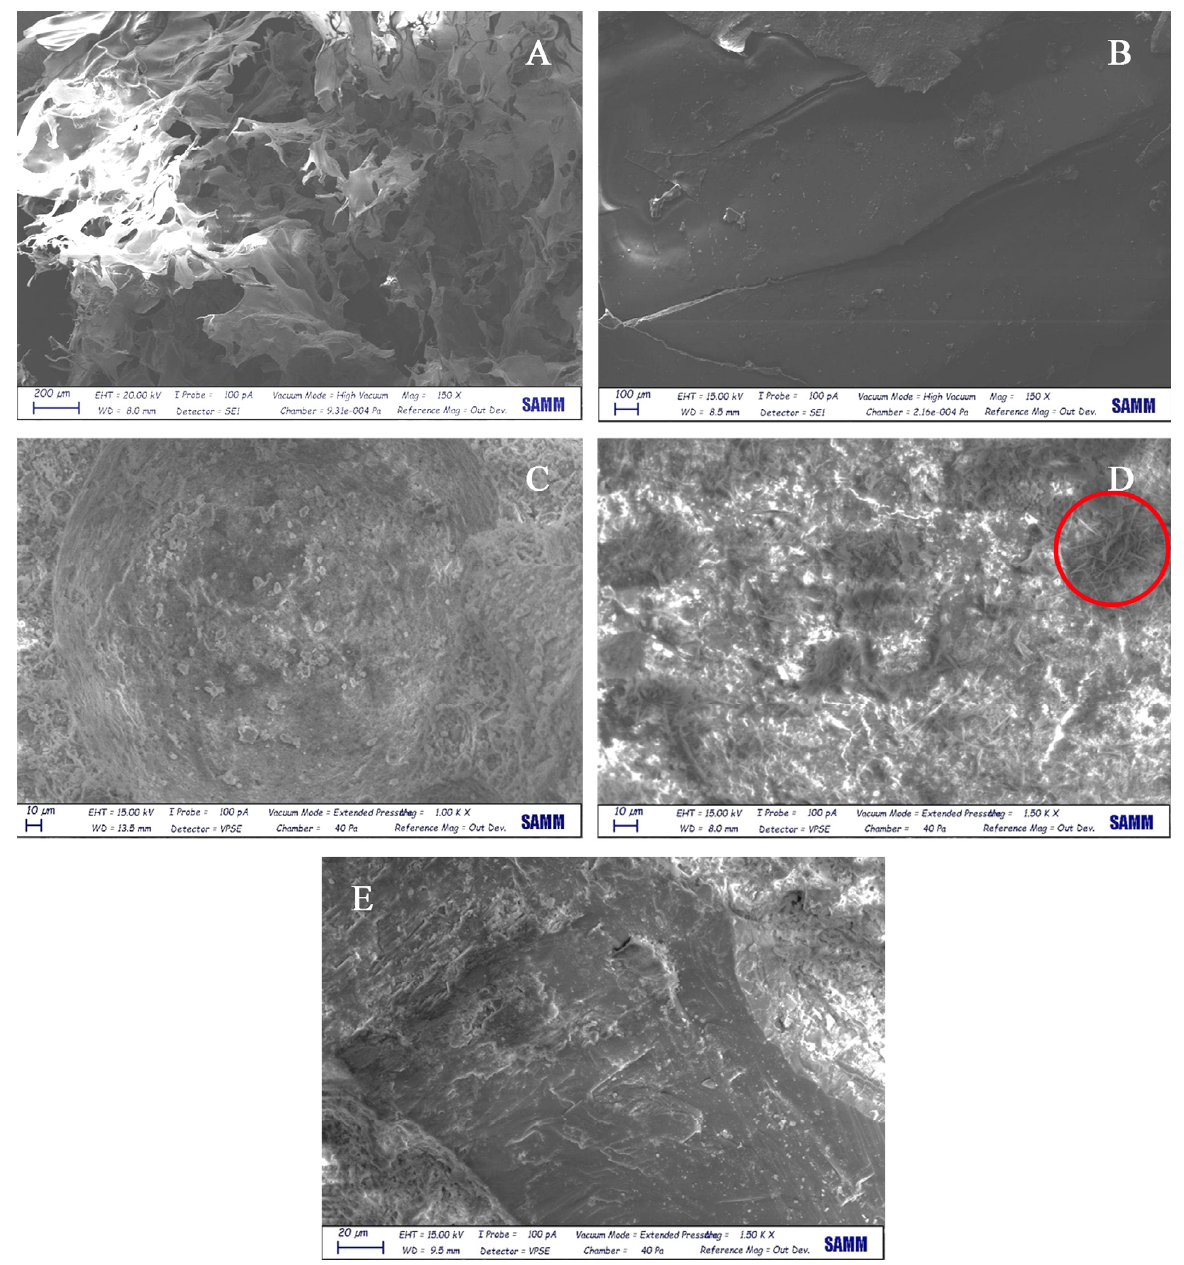
Figure 8. SEM analyses. ( A ) Lyophilized ONC; ( B ) lyophilized ONC-GMA; ( C ) reference mortar (0% ONC); ( D ) mortar with 0.6% ONC; ( E ) mortar with 2.4% ONC.